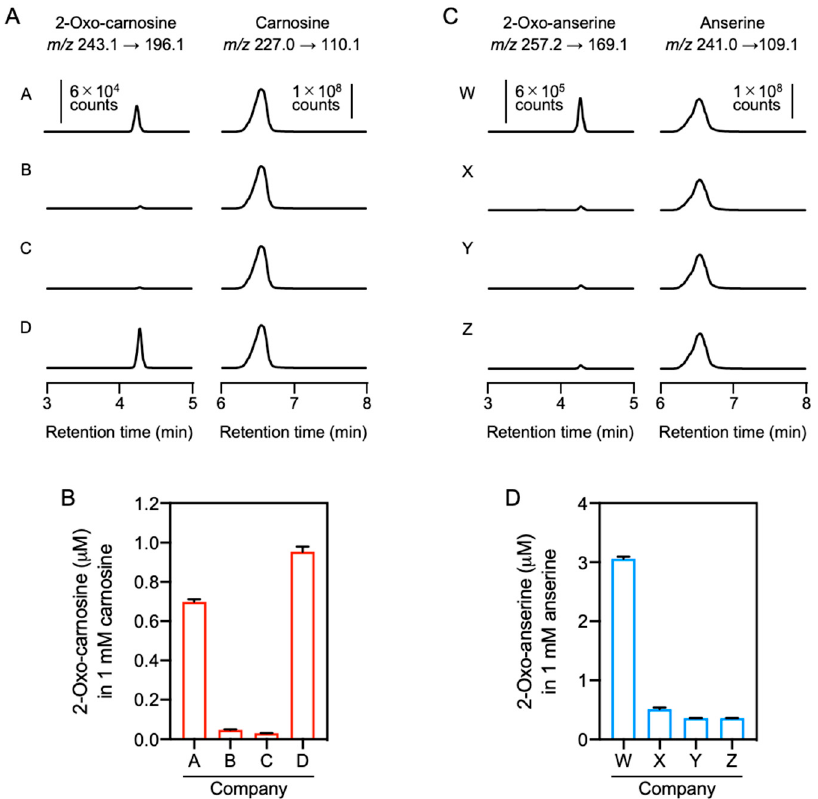
Figure 4. Contaminants including 2-oxo-IDPs in commercial IDPs standards. Different concentrations (2 and 80 mM) of commercial carnosine ( A ) and anserine ( B ) were analyzed by HPLC using an ES-502C 7C column. Representative HPLC chromatograms of the absorbance at 220 nm (left) and 250 nm (right) for the peptide moiety and the 2-oxo-imidazole moiety are indicated. Authentic 2-oxo-carnosine and 2-oxo-anserine (1 mM) were also analyzed by the same approach. Open, filled, and gray triangles indicate IDPs (i.e., carnosine and anserine), 2-oxo-IDPs (i.e., 2-oxo-carnosine and 2-oxo- anserine), and unidentified components, respectively.